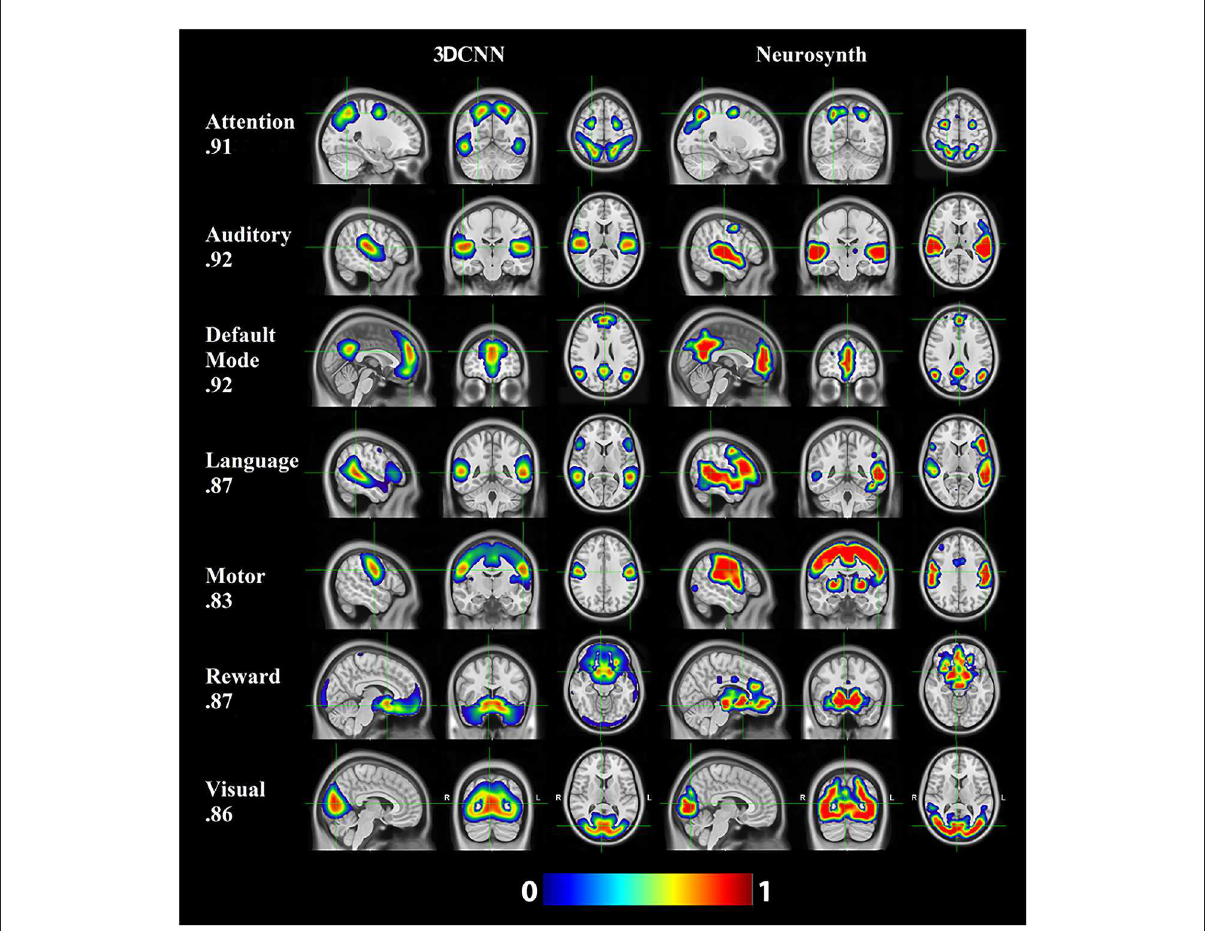
FIGURE6 3DCNN results computed over the MSC data and functional maps generated from the Neurosynth platform. Of the networks evaluated, default mode (DMN), auditory (AUD), and attention [corresponding to dorsal attention (DAN)] showed the greatest structural similarity as measured by the